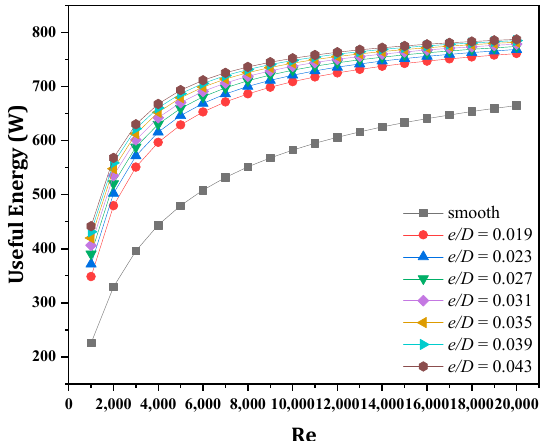
ened surfaces at various pitch ratios 𝑝 𝑒⁄ (in the range 6 – 12 ).